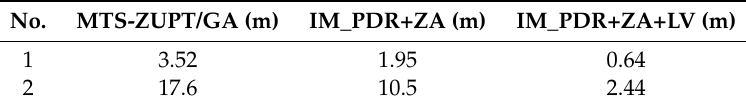
Table 8. Maximal positioning errors of different